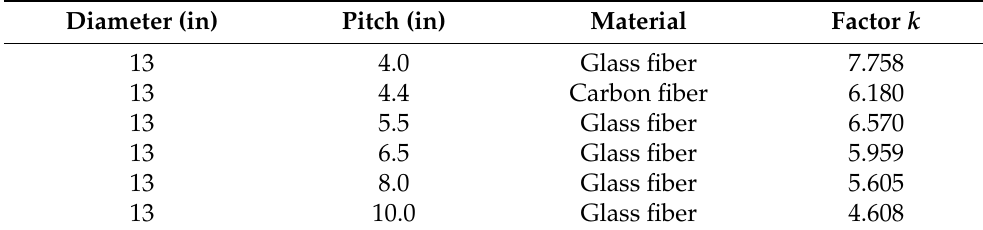
Table 1. List of propellers